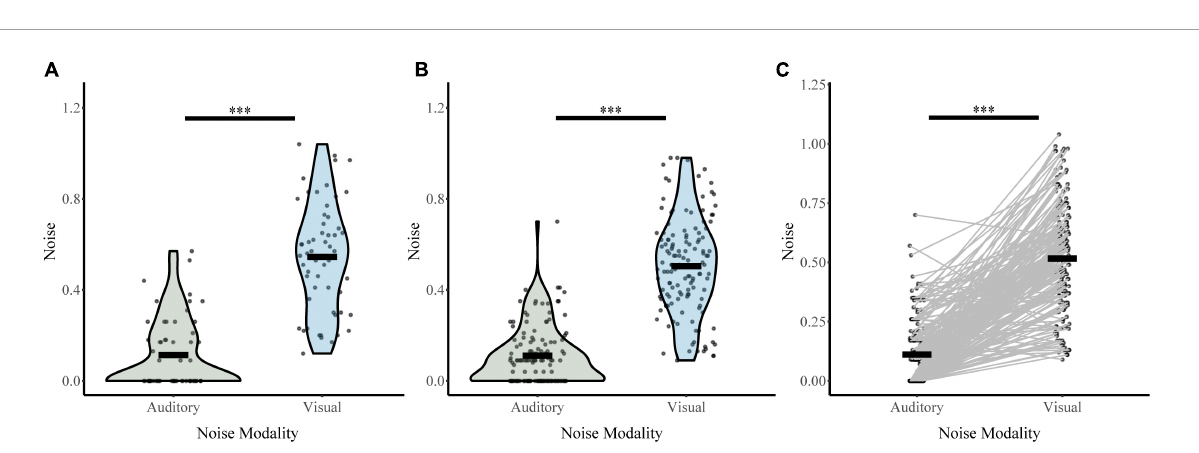
FIGURE4 Sensory noise for distractor free blocks. Auditory and visual sensory noise is shown separately for the auditory distractor (A) and visual distractor (B) groups. Horizontal black bars indicate group averages, and violin plots display the distribution of sensory noise in each modality for each task. Panel (C) shows auditory and visual sensory noise for all participants connected for each participant with straight lines. ∗∗∗ Indicates p <